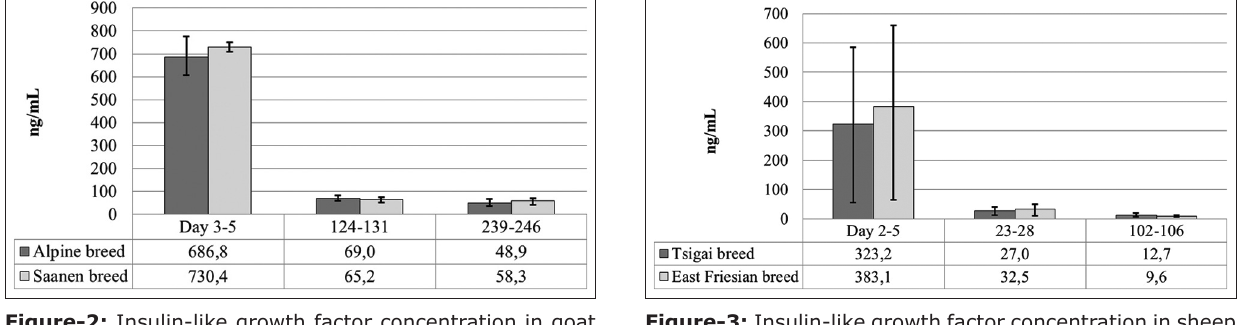
Figure-2: Insulin-like growth factor concentration in goat milk; n = 10.